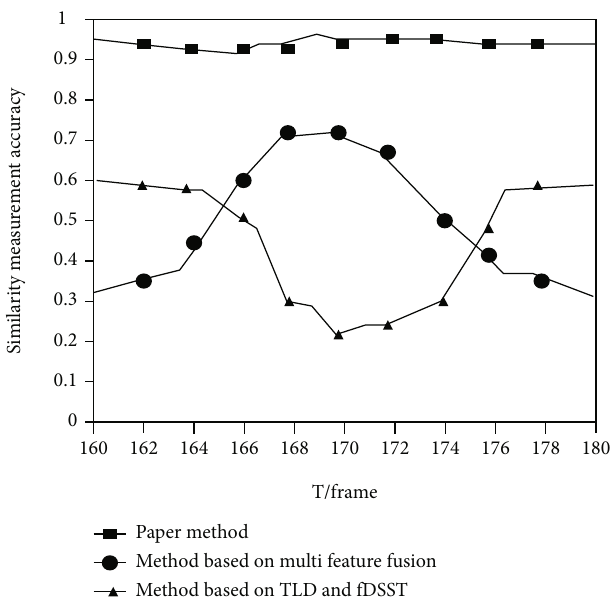
Figure 7: Comparison results of feature similarity measurement accuracy.